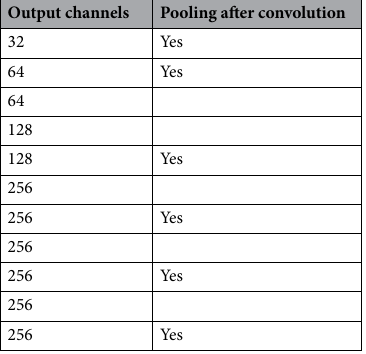
Table 1. Output channels for the convolutional part of the network. All layers (including pooling) have 3 × 3 kernels. All convolutional layers are followed with batch normalization and LeakyReLU